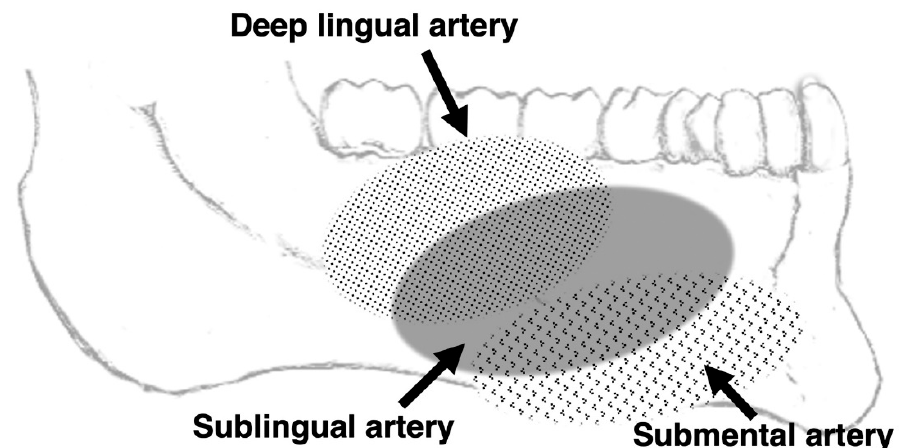
Figure 2. Image from 3D MRA using SSFP showing the mediodistal ranges of the visualized lingual and sublingual arteries with reference to the dentition.